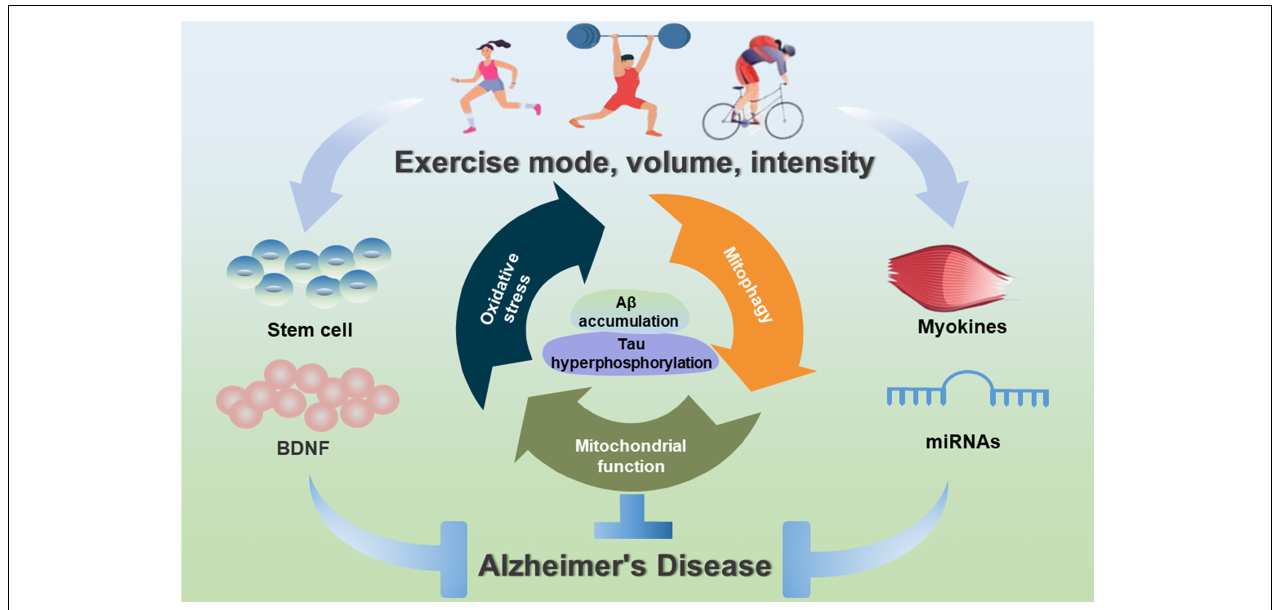
FIGURE 3 | Exercise-induced benefits of mitochondrial-targeted therapeutics for AD. Exercise interventions can contribute to mitochondrial health, inhibit oxidative stress, improve mitochondrial biogenesis and mitochondrial dynamics, and induce mitophagy, and stimulate myokines, miRNAs and stem cells to improve mitochondrial function during the prevention and treatment of